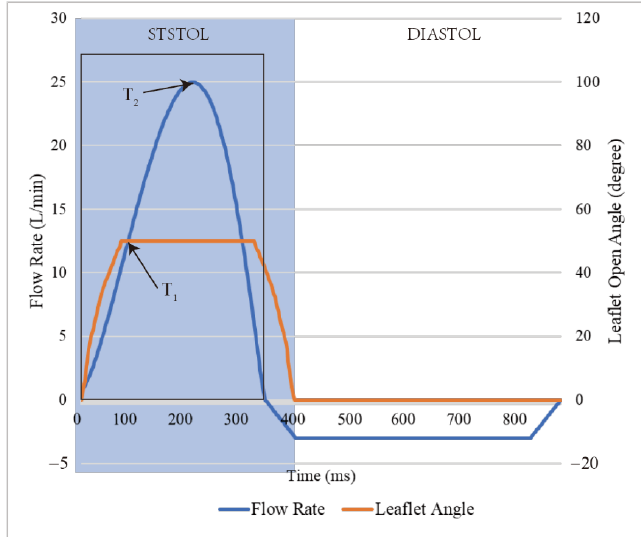
Figure 3. Flow rate pulse of the aorta inlet and leaflet open angle changes.